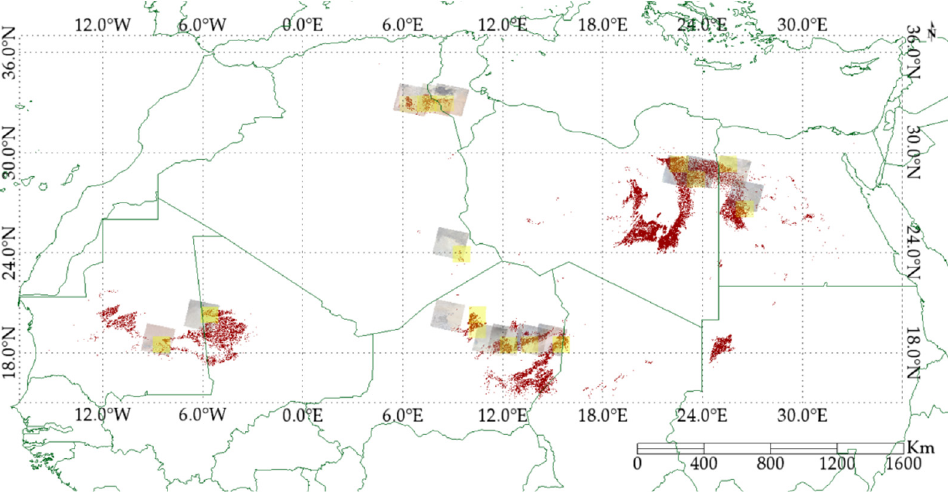
Figure 1. Cluster 13 pixels across North Africa. The red color represents Cluster 13 pixels, the yellow box represents Sentinel image footprint and the images lying on the Cluster 13 pixels are the Landsat 8 images for 15